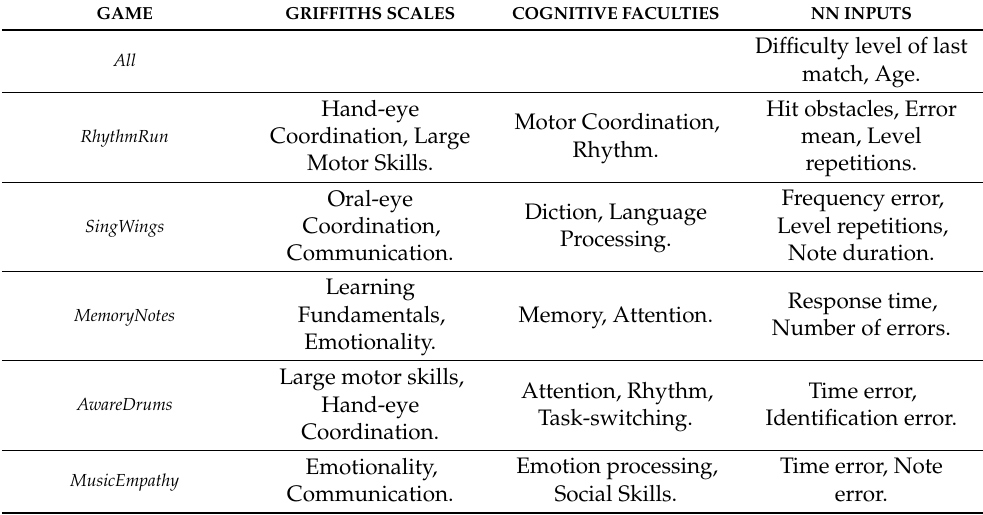
Table 2. Inputs of the Neural Network.